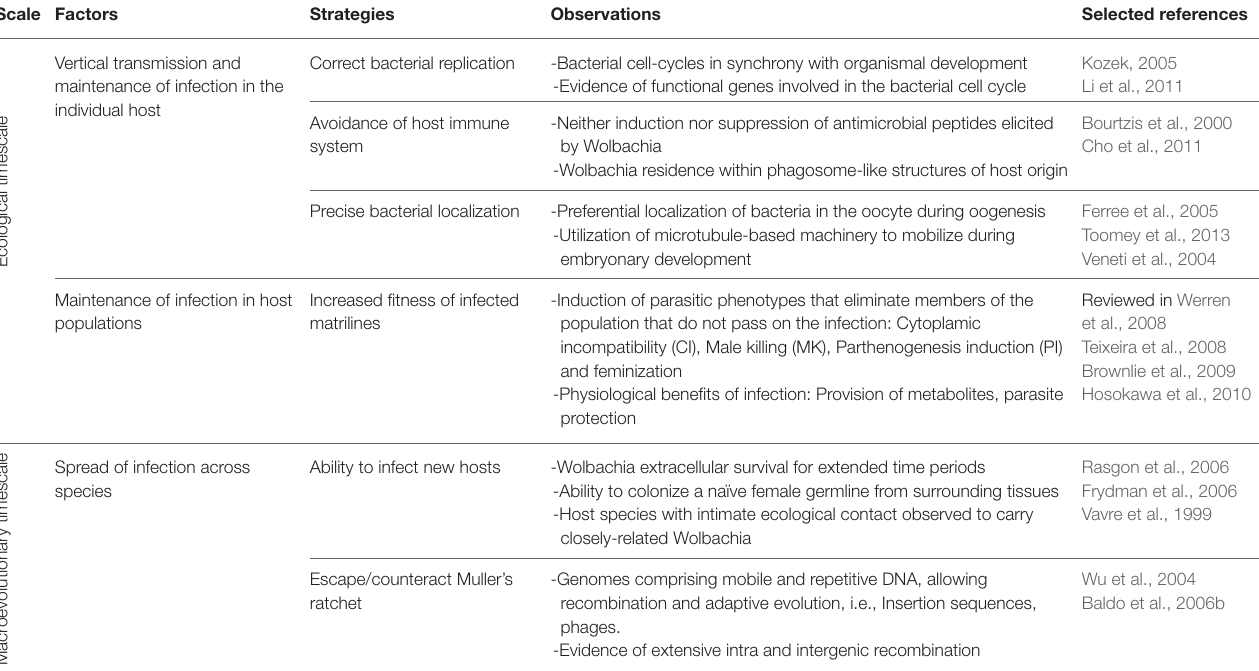
TABLE 1 | Factors that contribute to the evolutionary success of Wolbachia. Scale